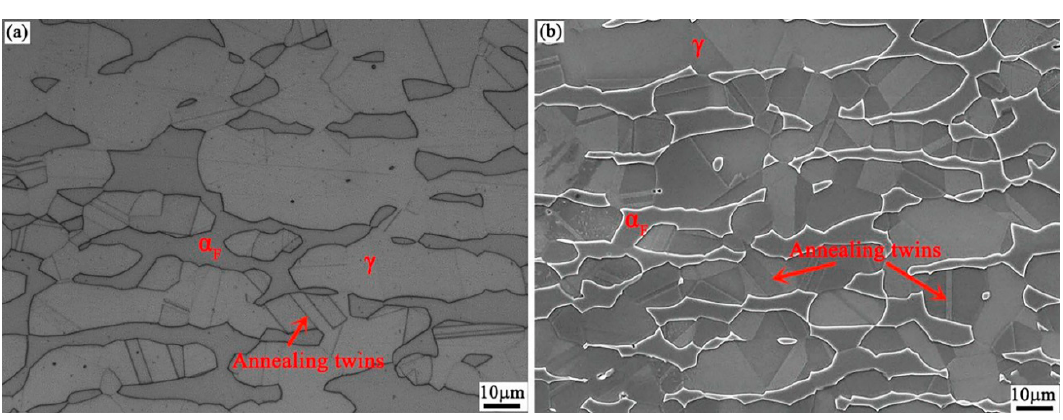
Figure 4. OM ( a ) and SEM ( b ) micrographs of the experimental steel before deformation at 25 °C ( ε = 0).